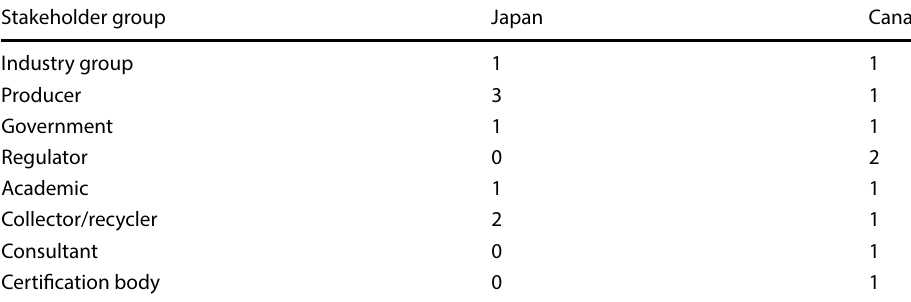
Table 3 Comparison of stakeholder representation between interviewees in Japan and